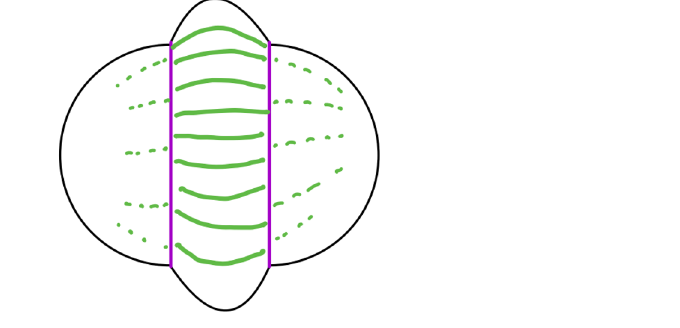
Figure 12 . Bit-threads emitted toward the pode and antipode encounter a bottleneck of zero